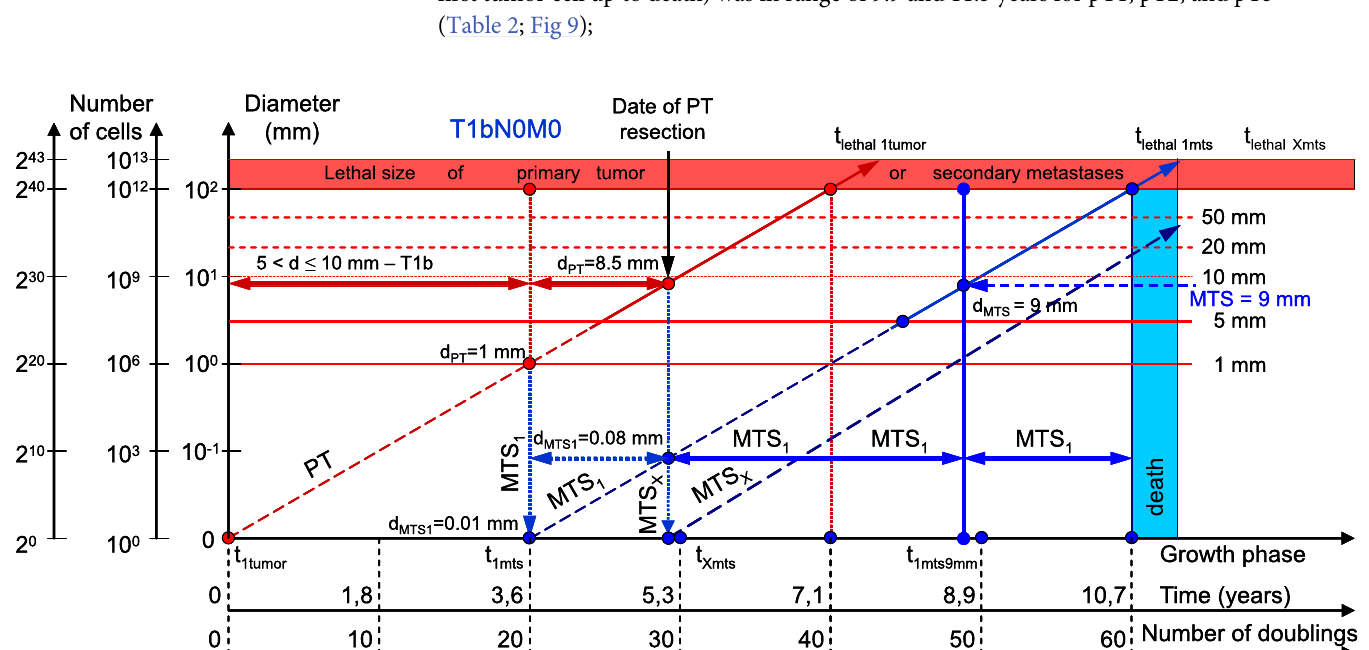
PLOS ONE | https://doi.org/10.1371/journal.pone.0200148 July 6,